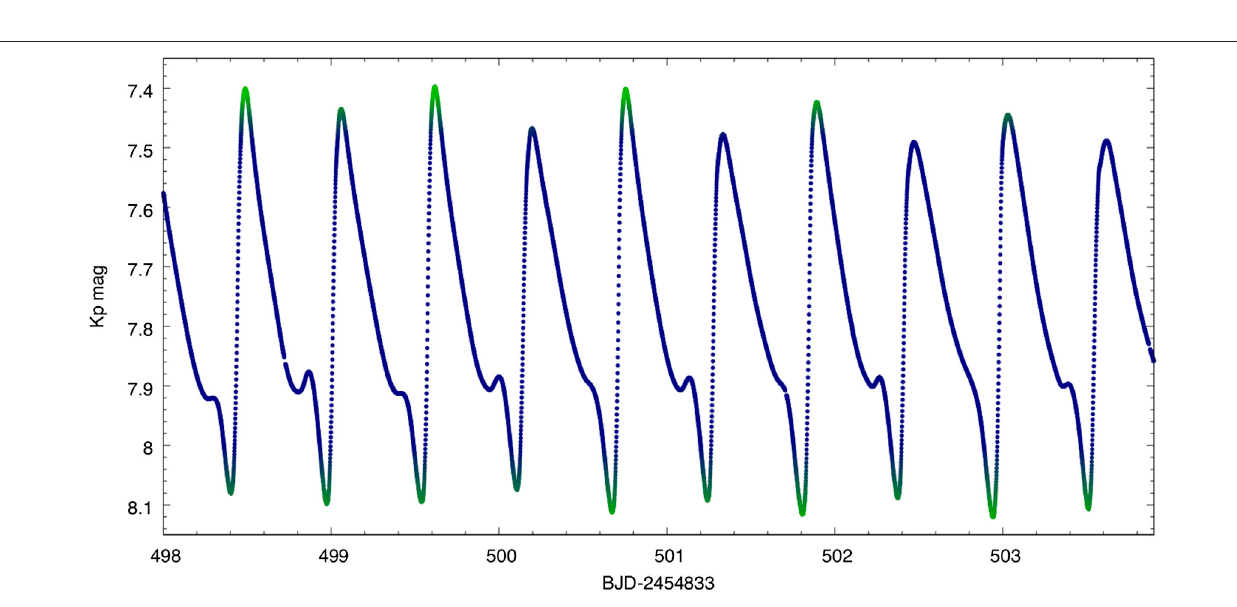
modes of an RR Lyrae model as a function of the effective temperature. Periods are scaled with the fundamental mode. Deviations in the nonadiabatic period ratios are most pronounced around 4.5, indicating the presence of strange